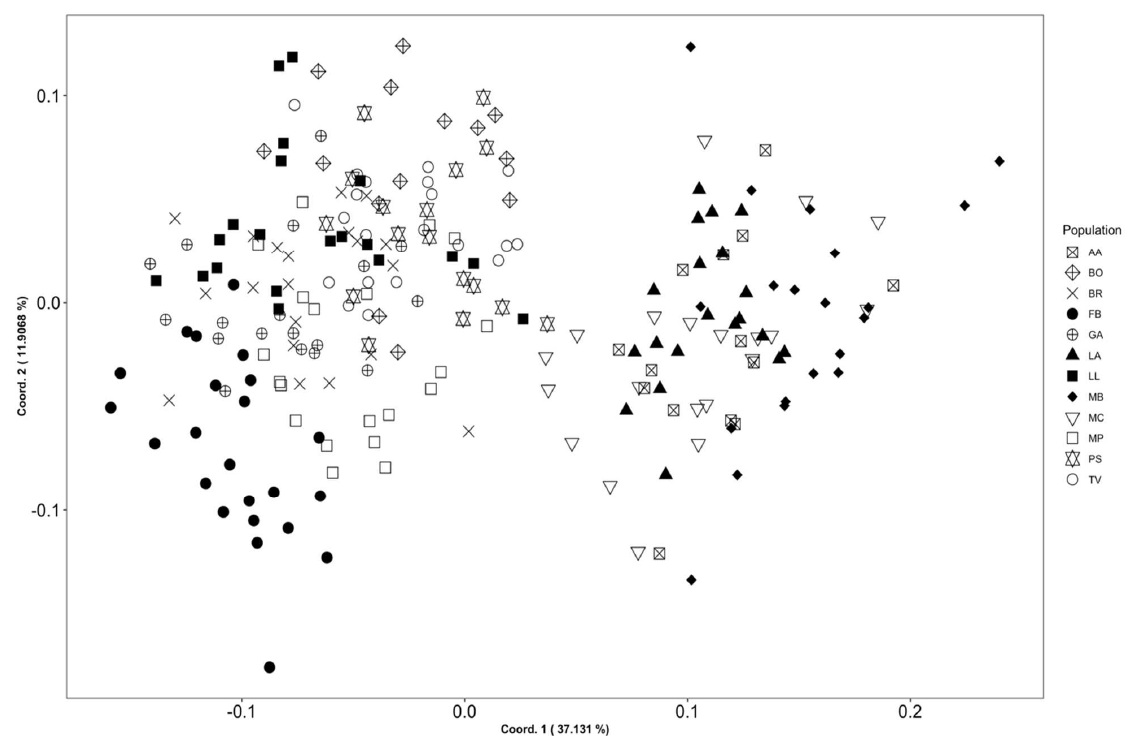
Figure 1. PCoA based on the 49 morphological characters measured in Armeria arenaria popula- tions. Solid symbols represent individuals from type localities of the four taxa studied. AA = Apuan Alps, N Apennines; BO = Bobbio, N Apennines; BR = Brusson, Pennine Alps; FB = Fon- tainebleau, Île–de–France; GA = Gambolò, West Po Valley; LA = Libro Aperto; N Apennines; LL = Le Lauzet, Dauphiné Alps; MB = Marmagna–Braiola, N Apennines; MC = Monte Cusna, N Apen- nines; MP = Monte Prinzera, N Apennines; PS = Piana di Salmezza, Lombard Prealps; TV = Terme di Valdieri, Maritime Alps. Further population details are provided in Table 1 and Figure 6. Along the second axis, the topotypical population of A. arenaria subsp. arenaria (FB) shows a slight separation from the other arenarioid populations (Figure 2). One–way ANOSIM showed that there was, indeed, a significant difference between FB and the rest of the arenarioid populations (BO, BR, GA, MP, PS, TV, and LL) (R = 0.6573, p = 0.001), confirming the separation shown along the second axis of PCoA. LDA performed on the current taxonomic hypothesis (Table 3) obtained an 87% correct classification and K = 0.8. The lowest value of sensibility was scored by A. arenaria subsp. marginata (77.7%), fol- lowed by A. arenaria subsp. apennina (85.4%). The percentage of correct classifications and K increased to 99% and 0.9696, respectively, when comparing arenarioid with margina- toid plants.